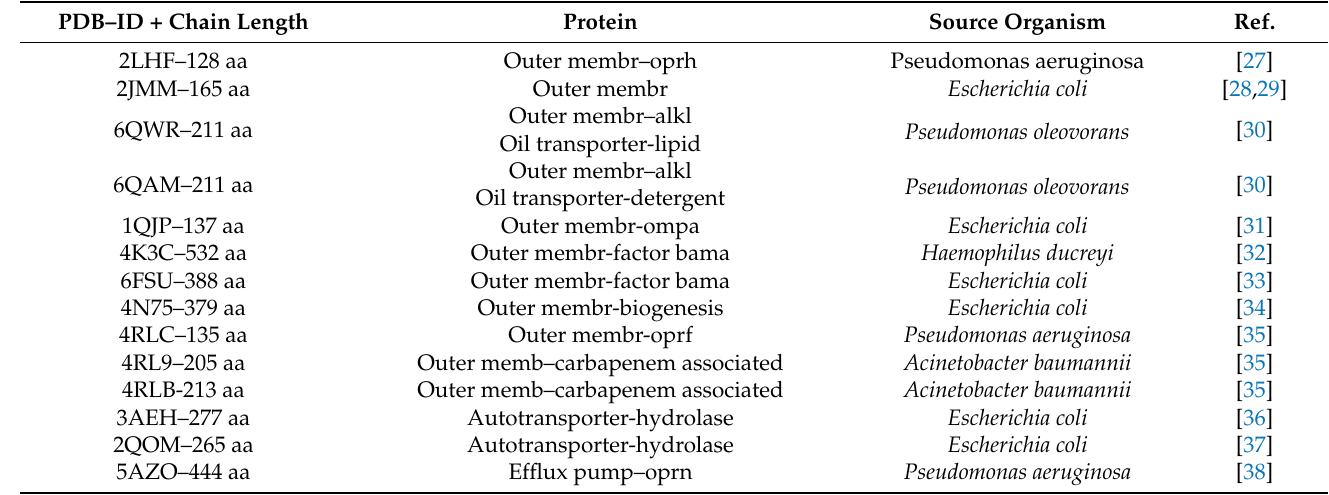
Table 1. List of the outer membrane proteins analyzed in the